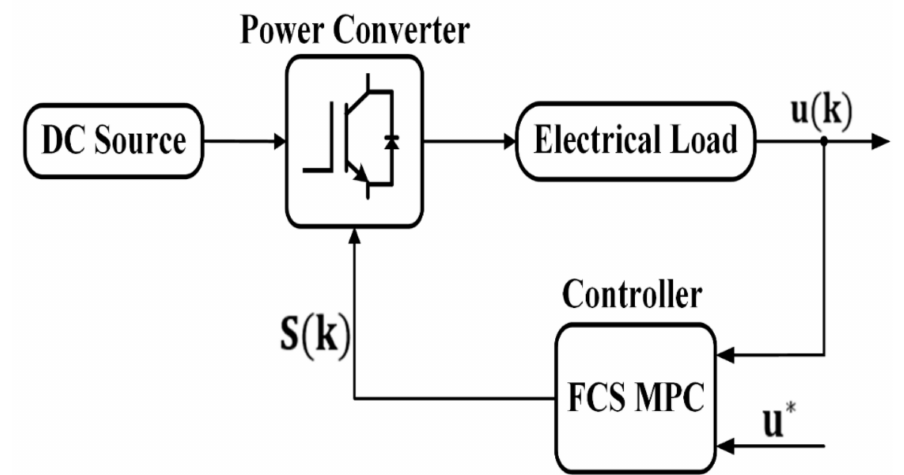
Figure 1. FCS PC